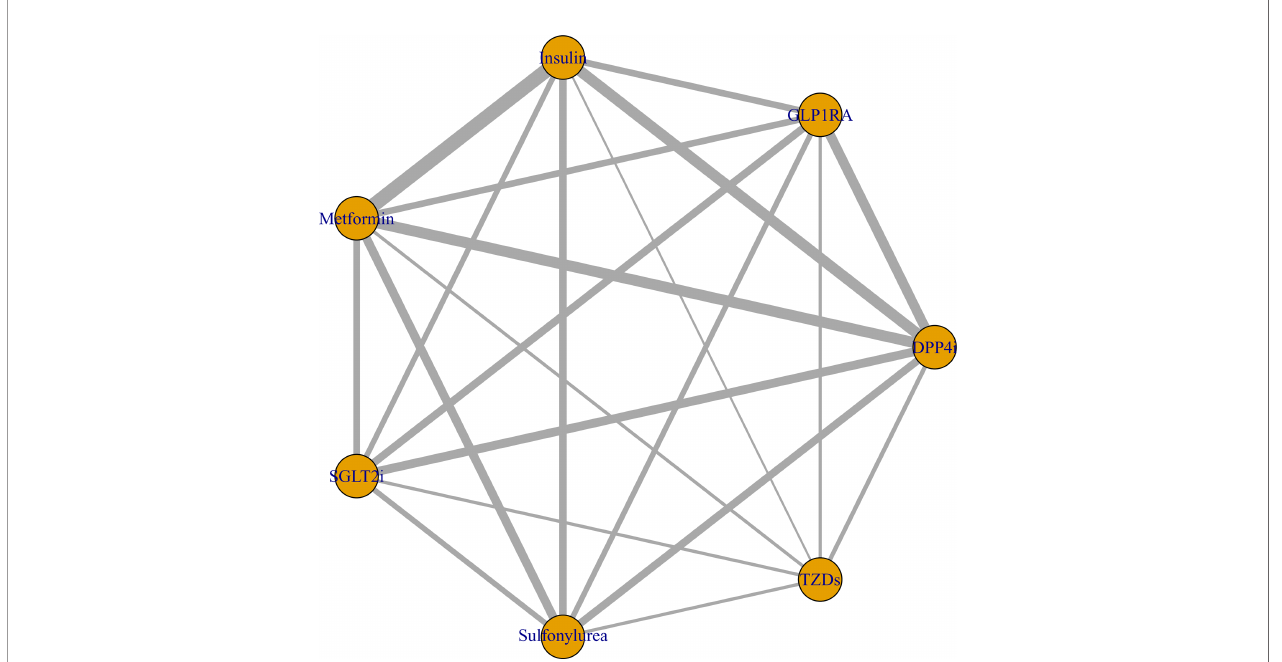
FIGURE 4 | Network plot of the association between different antidiabetic agents and the risk of COVID-19 mortality in diabetic patients. The thickness of lines corresponds to the number of trials.